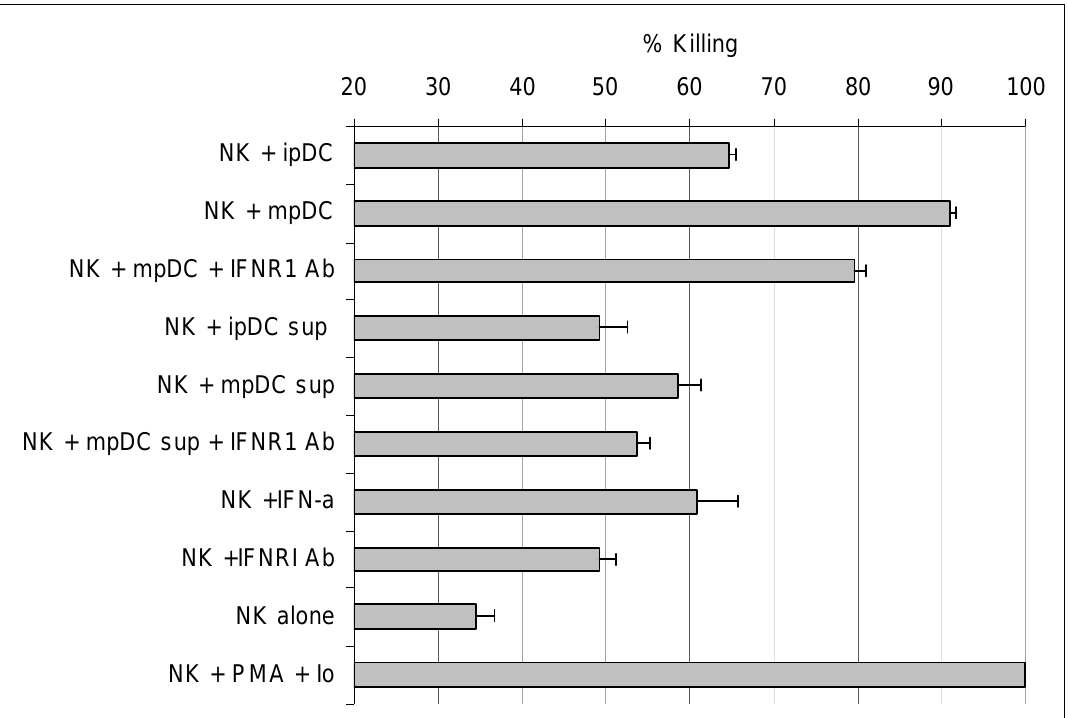
Figure 8 . NK specific cytotoxicity is induced by pDC in a contact dependent